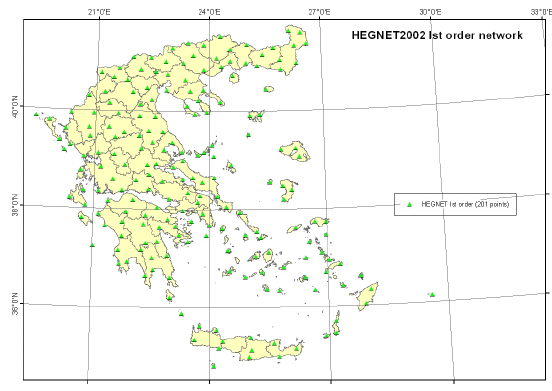
Figure 1: HEGNET2002 network referring in 1 st